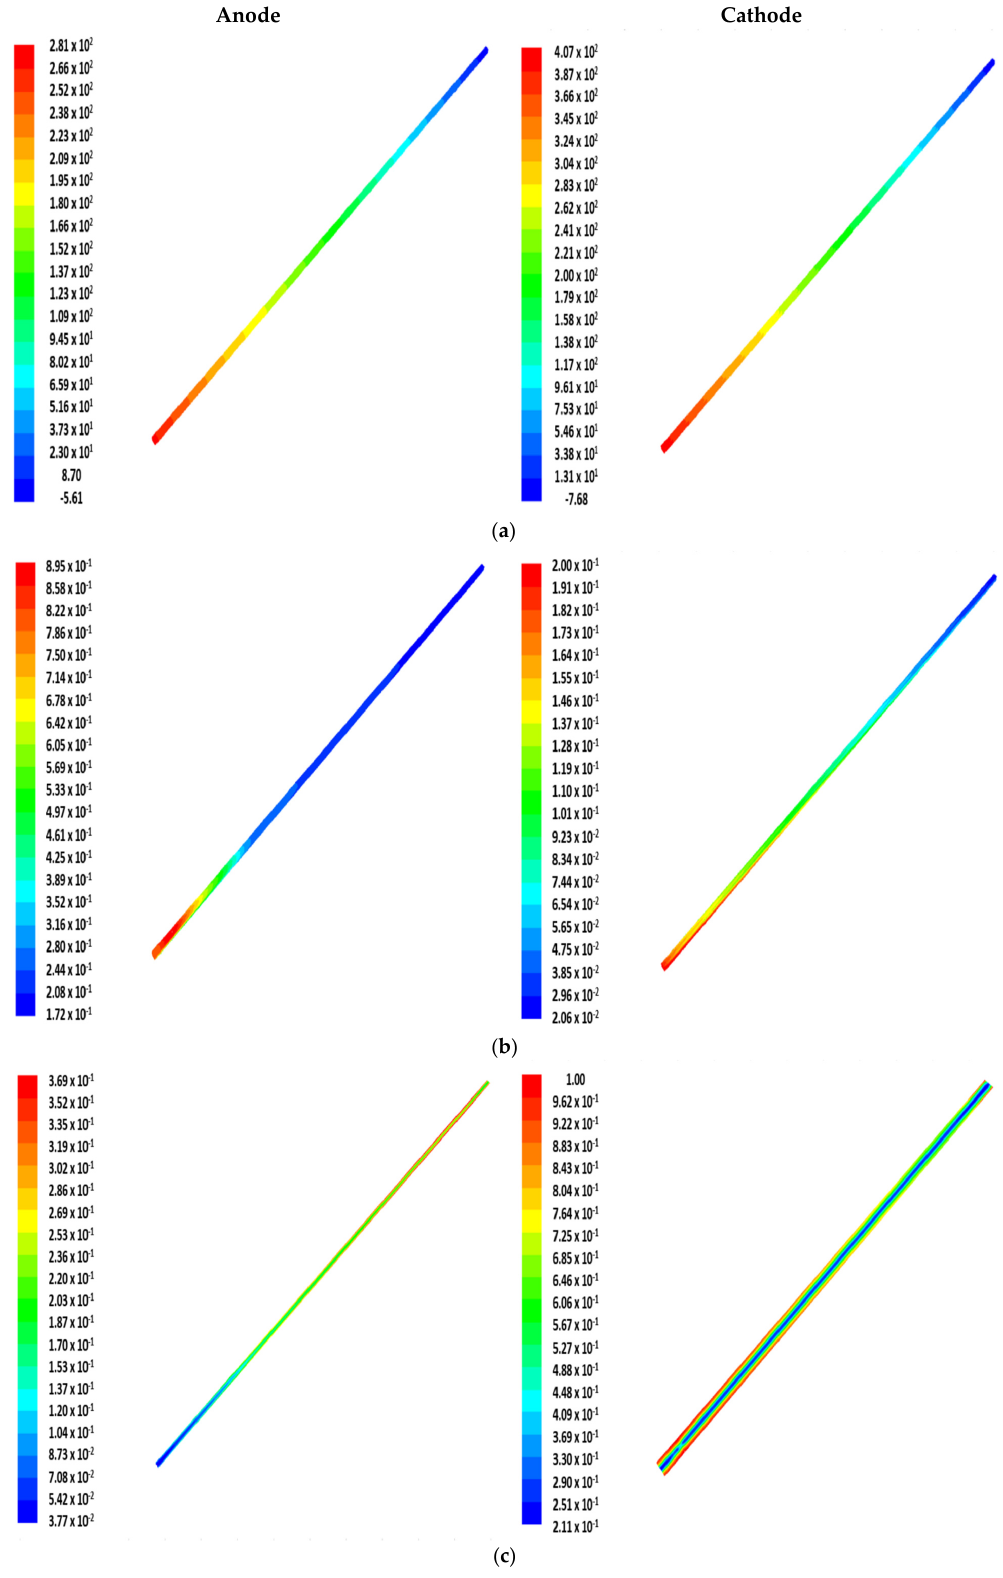
Figure 5. Contour of the single-channel model in terms of: ( a ) pressure distribution (Pa); ( b ) reactant distribution (kg/m 3 s); and ( c ) water content ( Ɵ ).